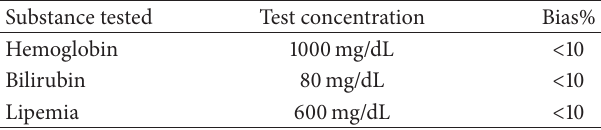
Table 4: Assay interference.